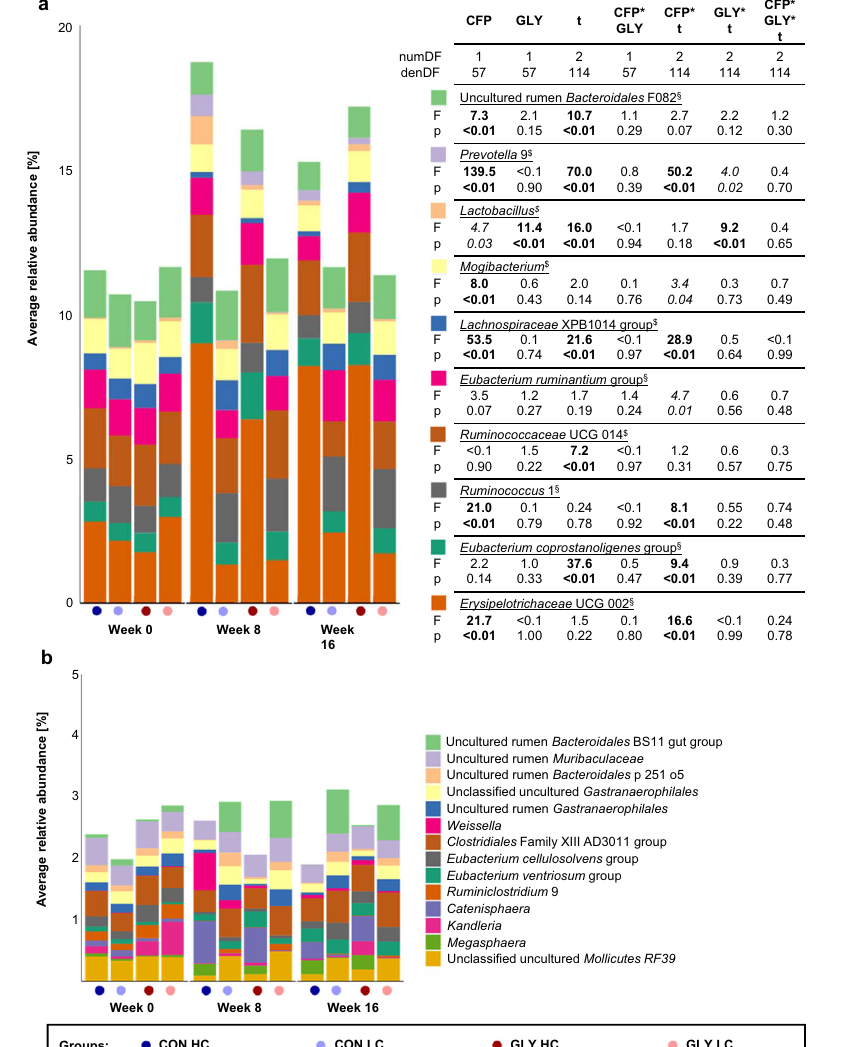
Fig. 6 Relative abundance of selected microbial taxons that were relevant for the separation of dairy cows fed with different concentrate feed proportions in the context of glyphosate contaminations in their diets. Relative proportions of the top 10 most abundant taxons (abundance >0.75% in at least one experimental condition) with a VIP score >1 together with in fl uences of the main experimental factors on their abundance as determined by a linear mixed effect model ( a ) and relative proportions of microbial taxons with VIP scores >1 and an abundance >0.2% in at least one experimental condition ( b ). CON: groups fed with a control diet, GLY: groups fed with a glyphosate contaminated diet, CFP: concentrate feed proportion, t : time, HC: groups with a high CFP, LC: groups fed with a low CFP, denDF: denominator degrees of freedom, numDF: numerator degrees of freedom, values in bold: p < 0.01, values in italics: p < 0.05, §: linear spatial covariance structure, $: unconstrained covariance